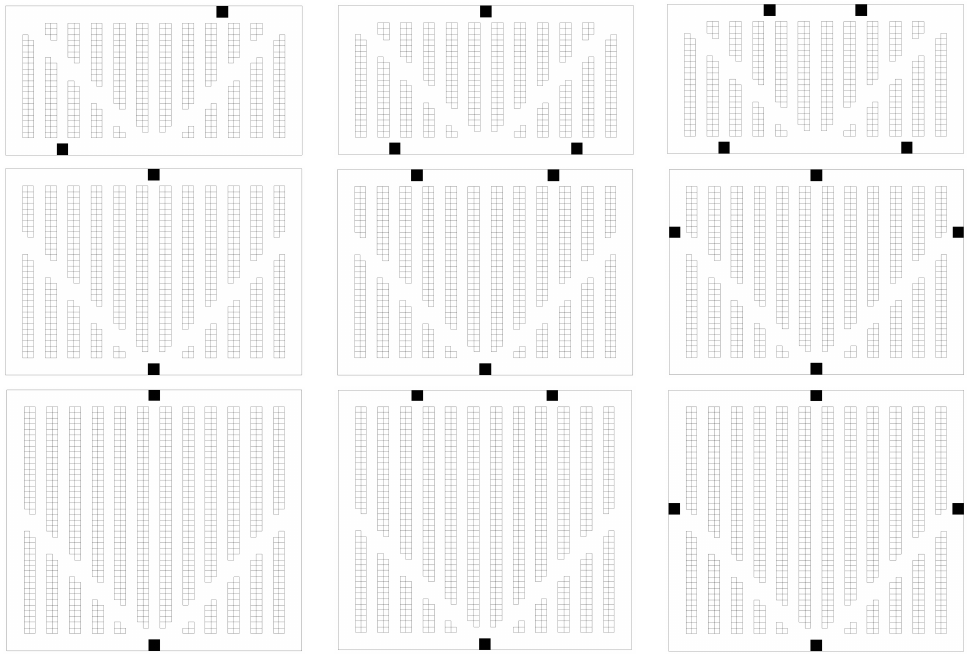
Figure A2. Optimal workstation layout in flying-V warehouses ( N = 24; L = 20,30,40; K = 2,3,4).